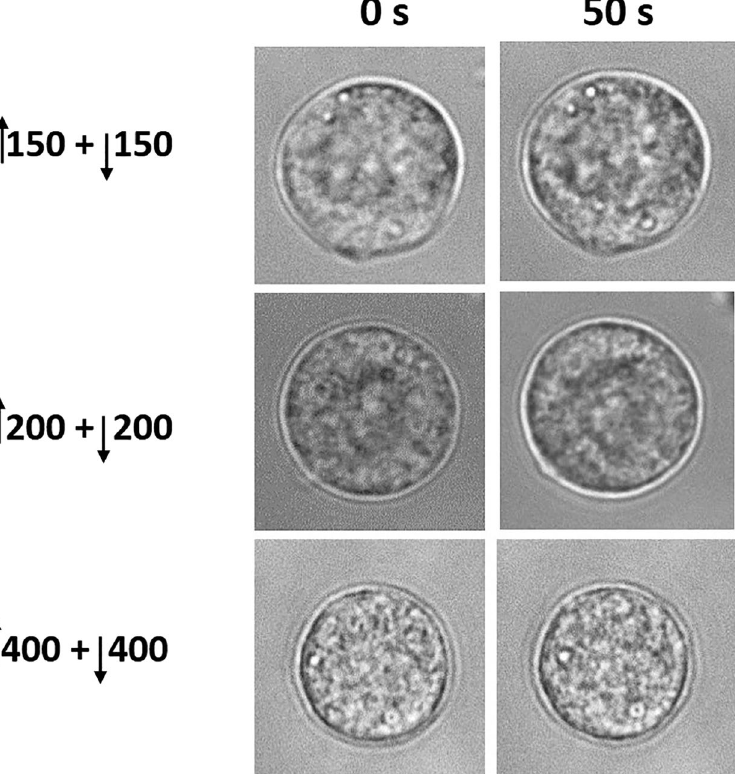
Figure 3. Representative bright field images of cells exposed to bipolar pulses. Images of the cells were captured before (0 s) and 50 s after exposure to a ↑ 150 + ↓ 150 ns, ↑ 200 + ↓ 200 ns, and ↑ 400 + ↓ 400 ns pulse. The E-field amplitude of each phase of each pulse duration was 3.1